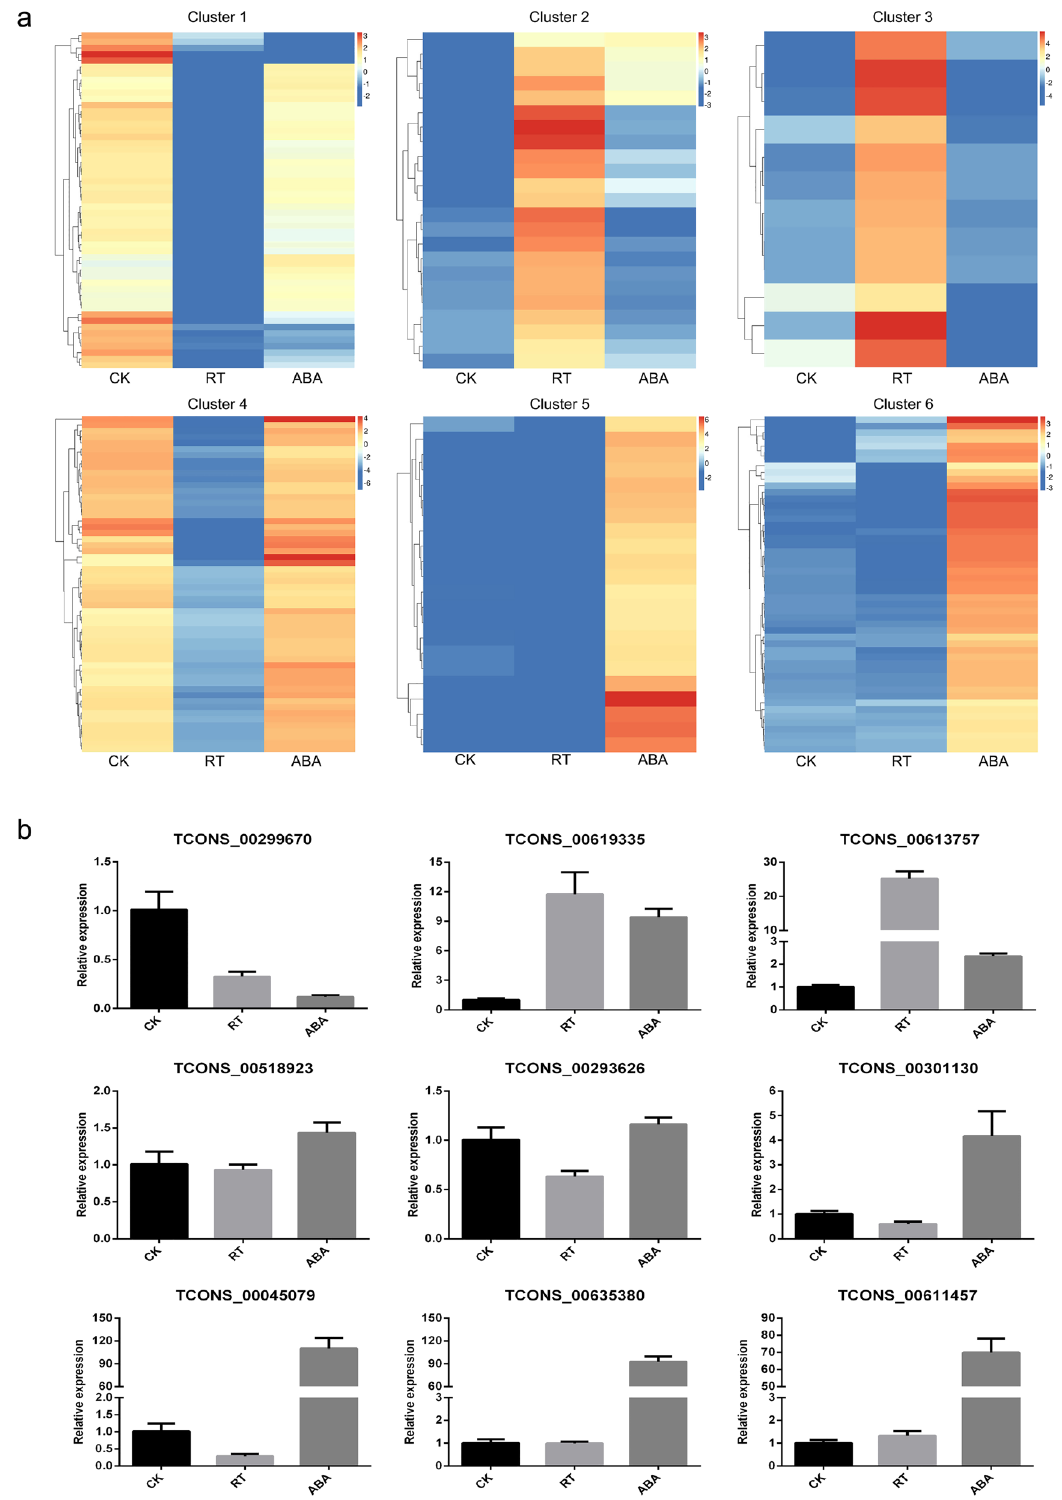
Figure 5. Clustering analysis ( a ) and qRT-PCR validation ( b ) of differentially expressed lncRNAs in kiwifruit. CK, freshly harvested fruits (fruit maturity stage); RT, fruits stored at 25 °C for 7 days (postharvest ripening stage); ABA, fruits treated with 50 mg/L ABA for 2 min and then stored at 25 °C for 7 days (softening